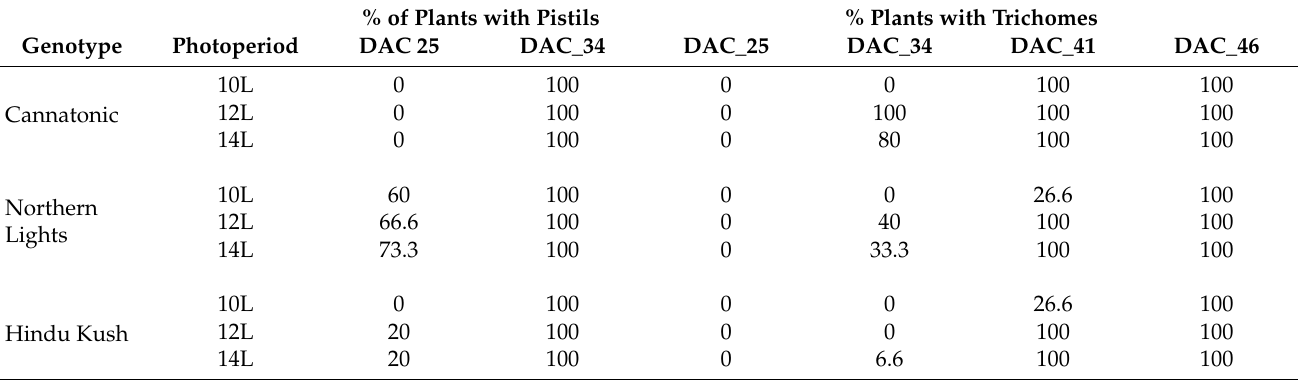
Table 1. Reproductive development in the three starting photoperiods. The % of plants showing the presence of pistils and trichomes is shown for difference days after cloning (DAC). N = 15. % of Plants with Pistils % Plants with